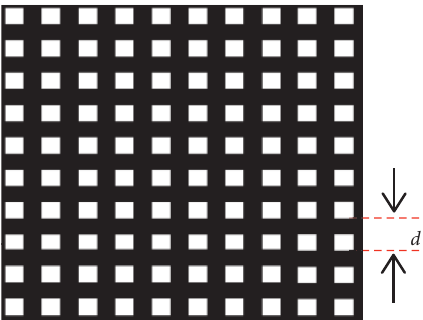
Figure 2: Schematic diagram of the two-dimensional square hole grating.